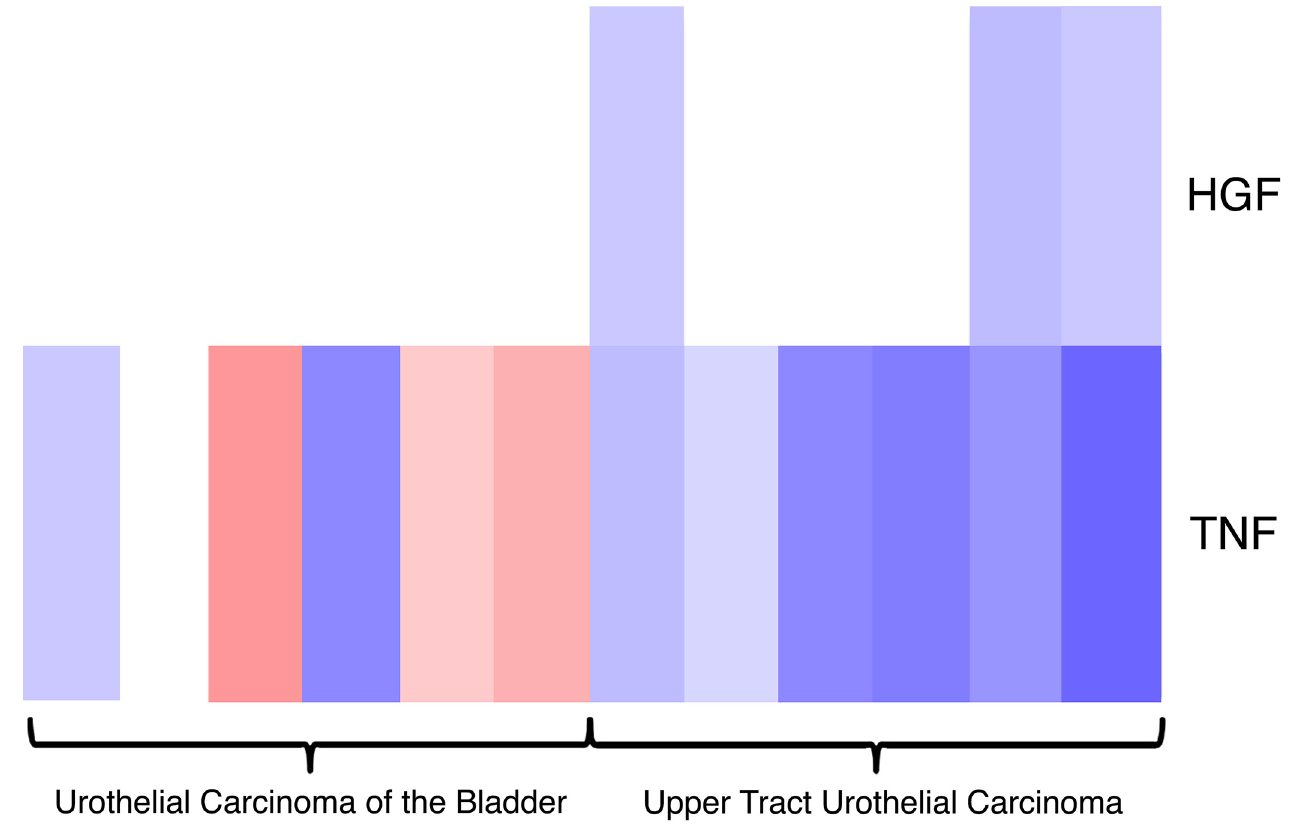
Fig 3. Pathway analysis shows low expression of HGF and TNF in upper tract urothelial carcinoma. Blue indicates lower expression and red indicates higher